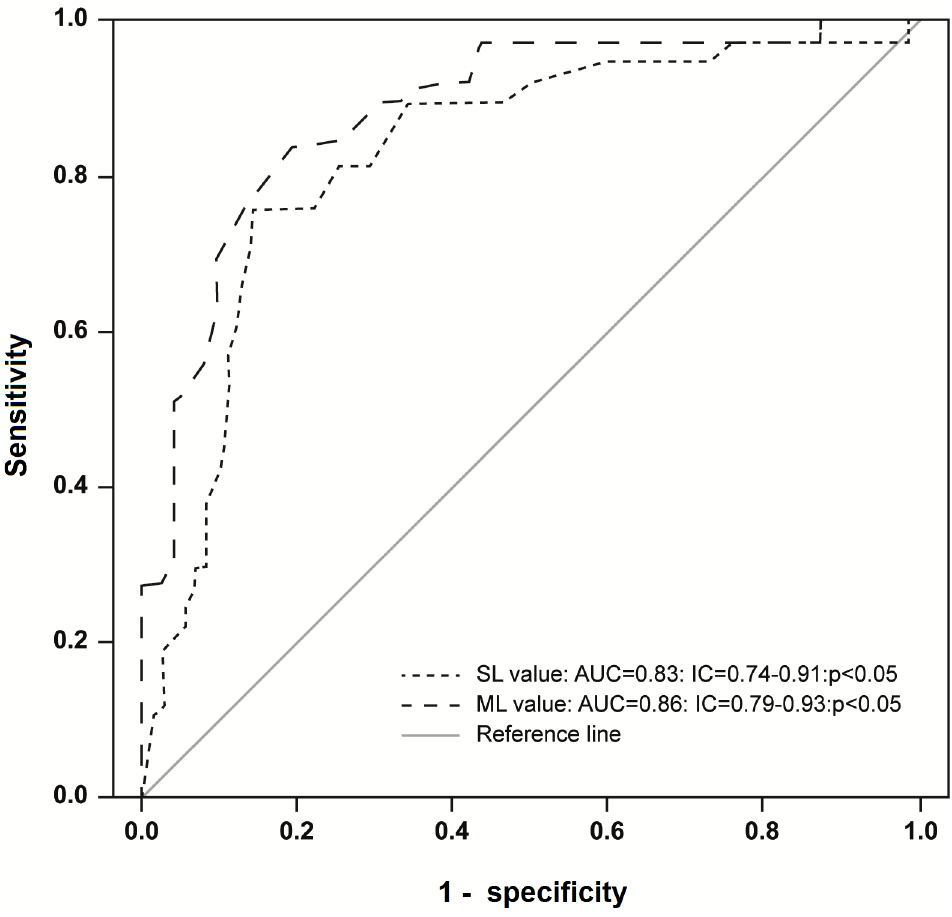
Fig 3. Short-latency (SL) and medium-latency (ML) response receiver operating characteristic (ROC) curves for detecting spinal cord injury in patients infected with human T-cell lymphotropic virus type 1 (HTLV-1). AUC, area under the curve; IC, confidence